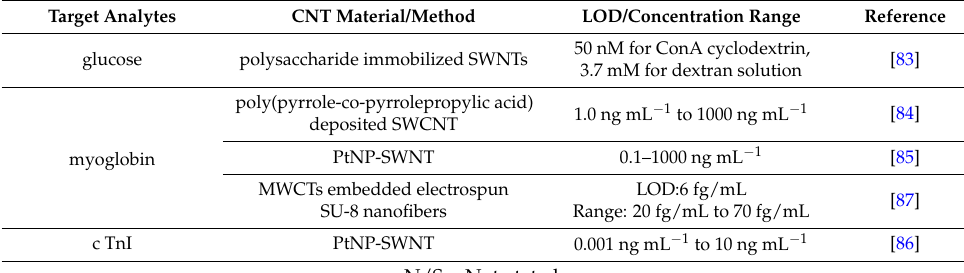
Table 4. Summary of sensing performance of chemiresistive